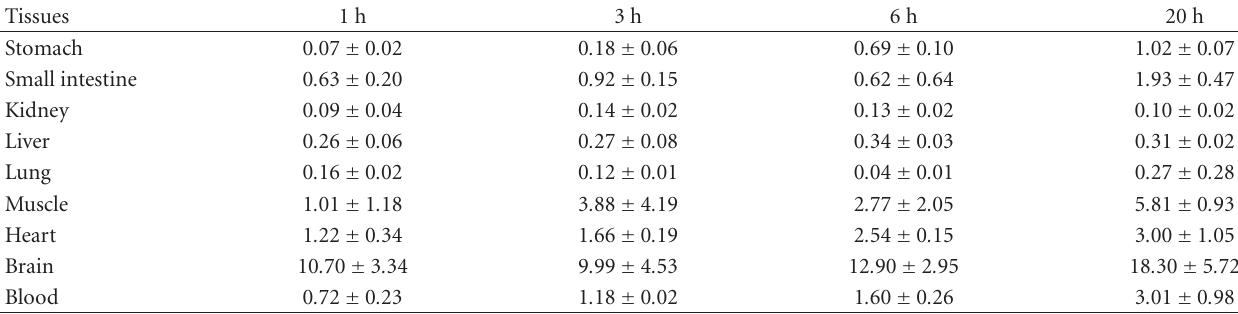
Table 3: T/NT of 99m Tc labeled compound 5 at various time intervals in nude mice bearing human colonic cancer xenografts ( n = 3, x ± SD). Tissues 1 h 3 h